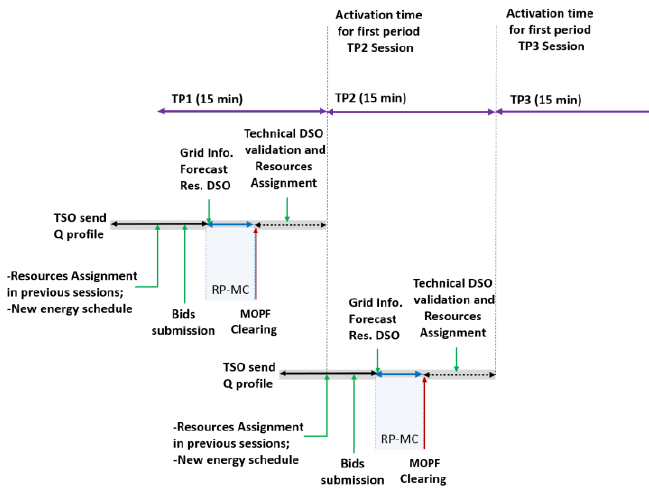
Figure 3. Time intervals and delivery horizon in a timeframe.